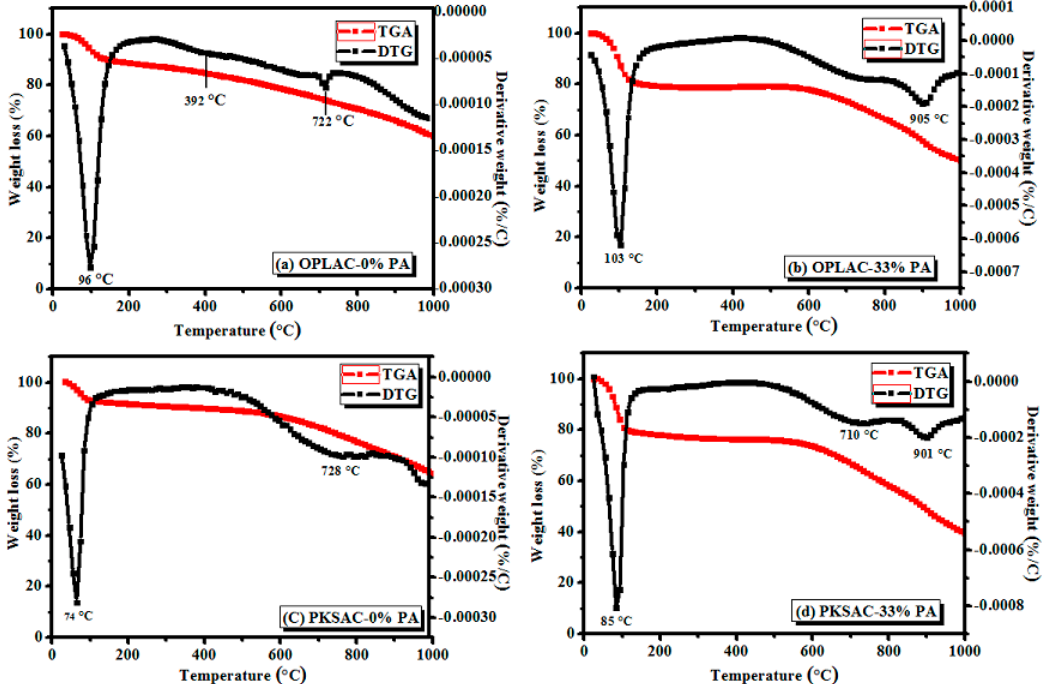
Figure 14. Thermogravimetric and differential Thermogravimetric (TGA and ∆ TG) curves of the OPL- and PKS-derived activated carbons (OPLAC and PKSAC), prepared by impregnation with 33% phosphoric acid (PA); carbonization-activation was performed at 900 °C.